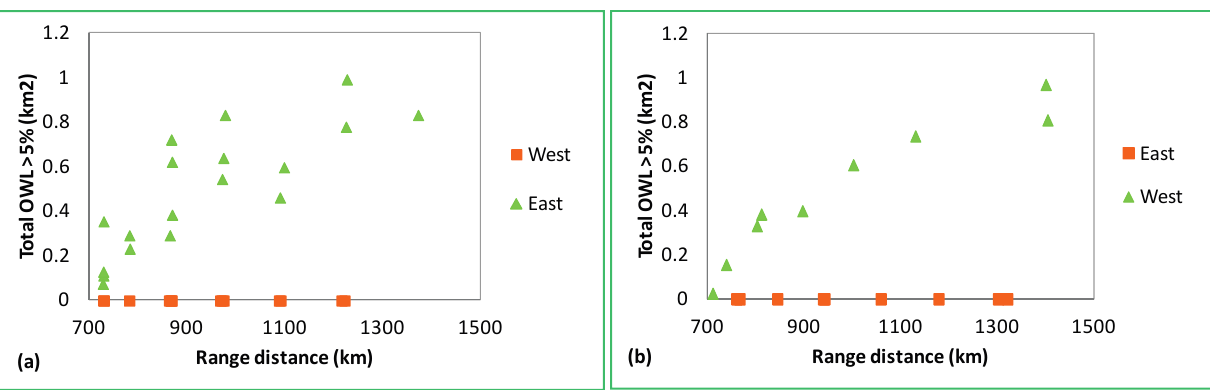
Figure 5. MODIS OWL flood extent for Site D2 for pixels mapping greater than 5% inundation plotted against range distance. The points are separated into those where the MODIS view angle is towards the sun, and those away from the sun for ( a ) MOD and ( b ) MYD data. For MOD data the direction of the sun is east, and for MYD it is west.